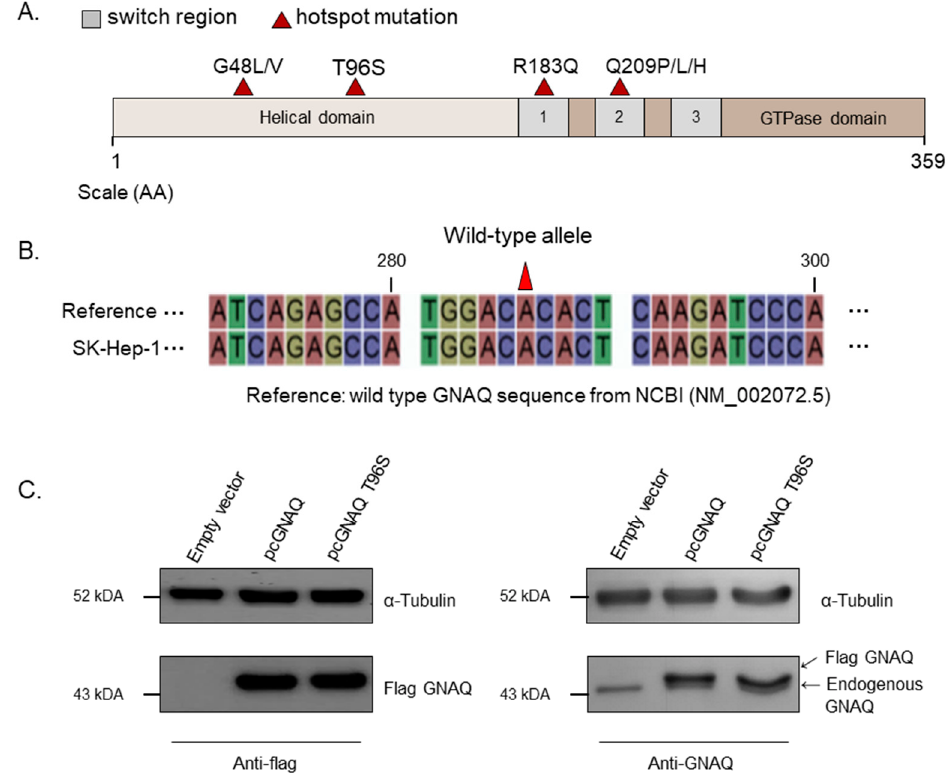
Figure 1. GNAQ T96S mutation. ( A ) Four hotspot mutations mapped in a schematic diagram of the GNAQ protein sequence (amino acids 1 to 359). Helical domain (beige), GTPase domain (brown), switch regions 1–3 (gray), and hotspot mutations (red triangles) are indicated. ( B ) The GNAQ sequence in the SK-Hep-1 cell line. The GNAQ sequence of SK-Hep-1 was analyzed and compared to the wild-type GNAQ reference sequence from the National Center for Biotechnology Information (NCBI; NM_002072.5). ( C ) Overexpression of the wild-type or the T96S mutant GNAQ. The control vector, pcGNAQ, or pcGNAQ T96S was transfected into SK-Hep-1 cells. After 24 h, a Western blot was performed to analyze the level of GNAQ protein using anti-Flag (left) or anti-GNAQ (right) antibodies in SK-Hep-1. Anti- α -tubulin antibody was used for normalization.